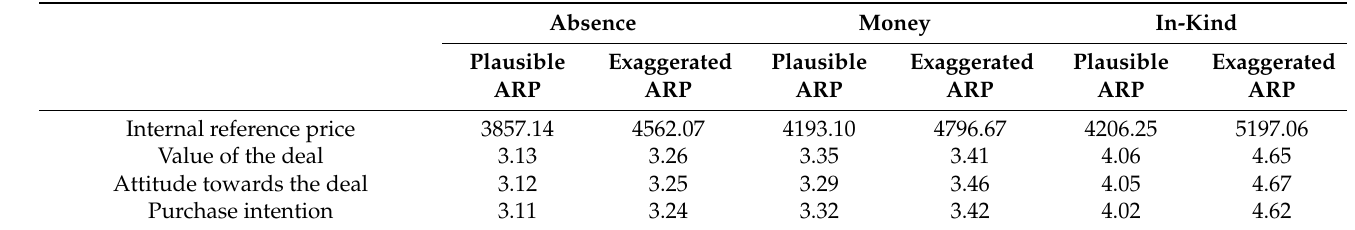
Table 4. Means of internal reference price, value of the deal, attitude towards the deal, and purchase